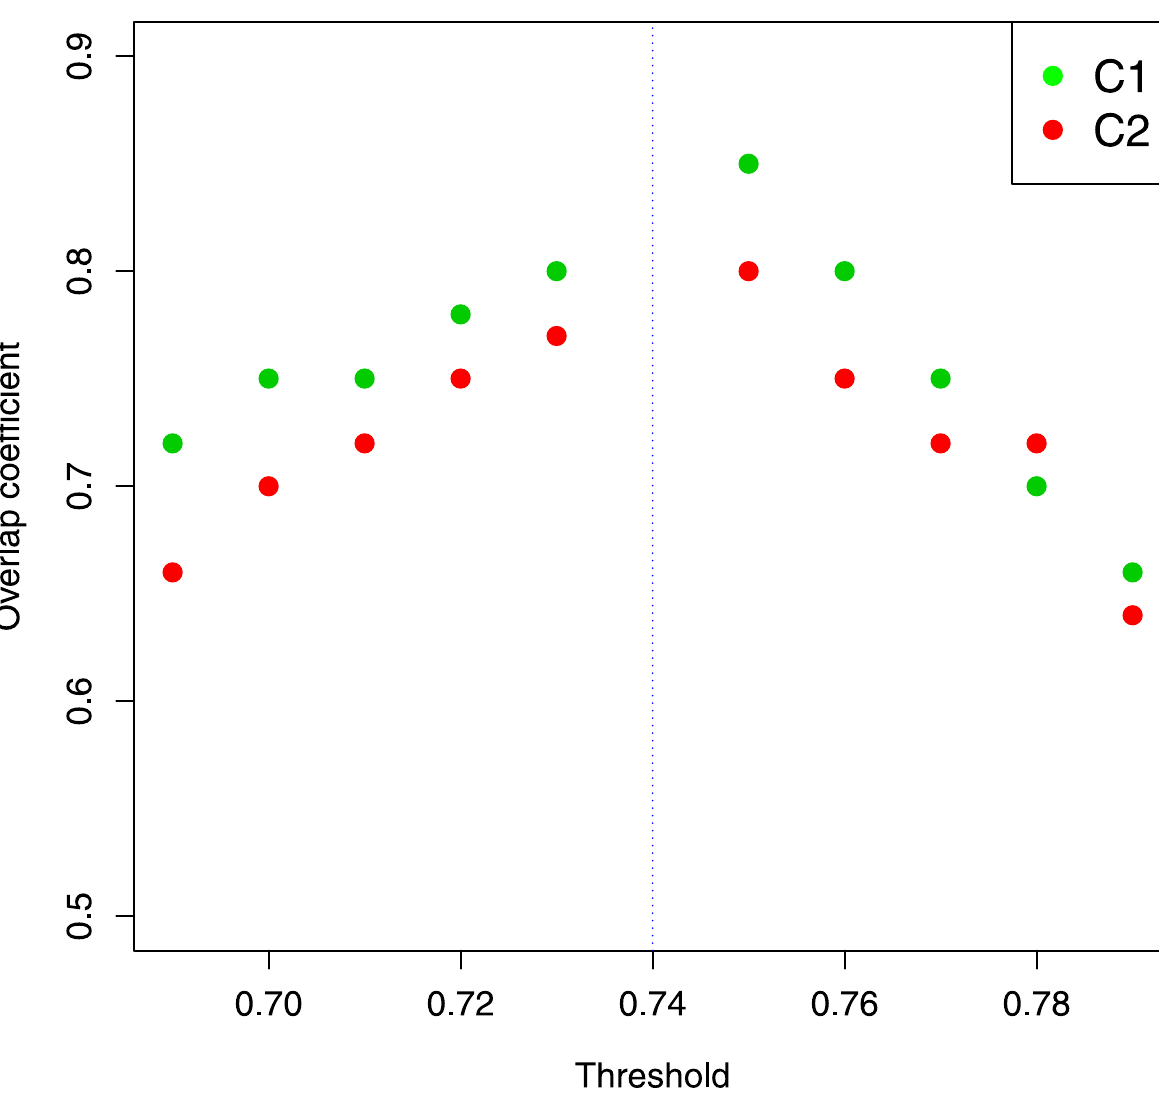
Fig 7. Overlap coefficient for C 1 and C 2 communities. The overlap coefficient as a function of threshold calculated in relation to the C 1 and C 2 communities. The dashed vertical line indicates the threshold value selected for our analysis.